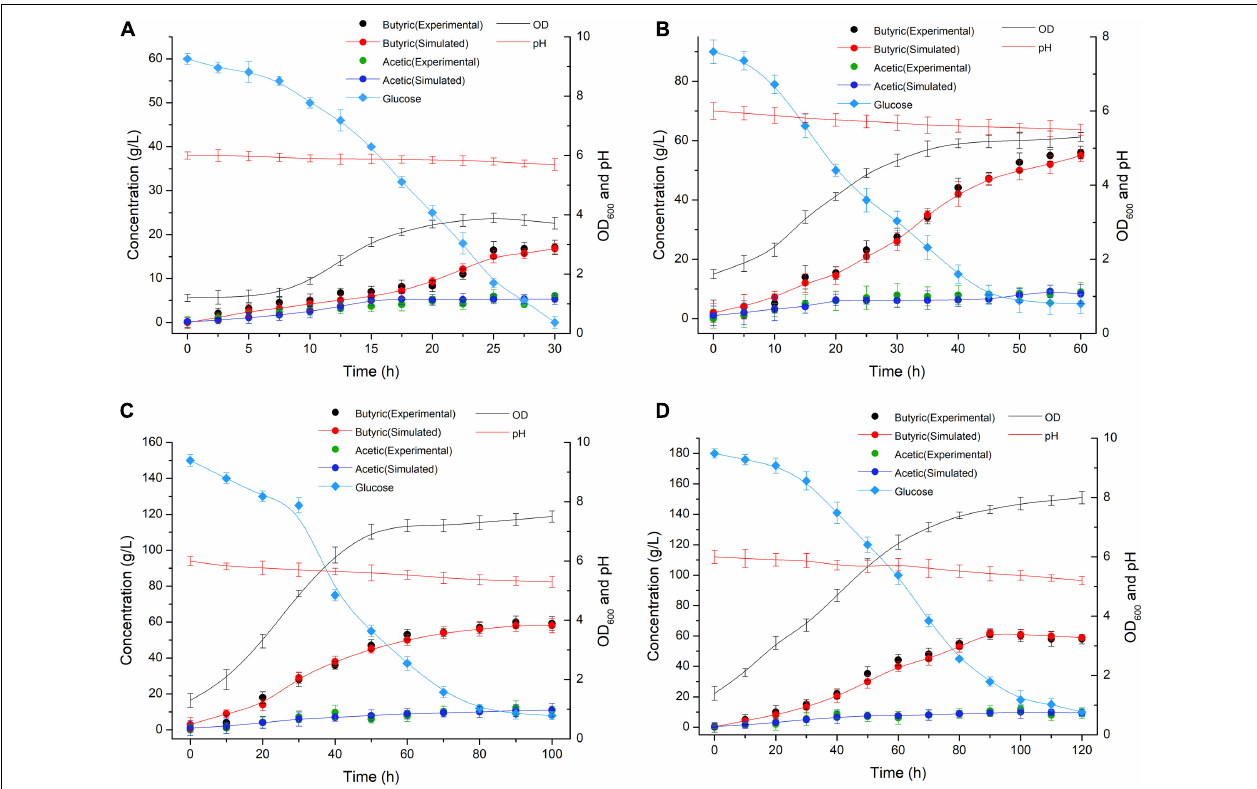
FIGURE 4 | Butyric (Experimental: black symbols; Simulated: red symbols and red lines) and acetic (Experimental: green symbols; Simulated: blue symbols and blue lines) acid production at different time points in the biofermentations of the C. tyrobutyricum mutant in media containing glucose concentration gradients of (A) 60 g/L, (B) 90 g/L, (C) 150 g/L, and (D) 180 g/L